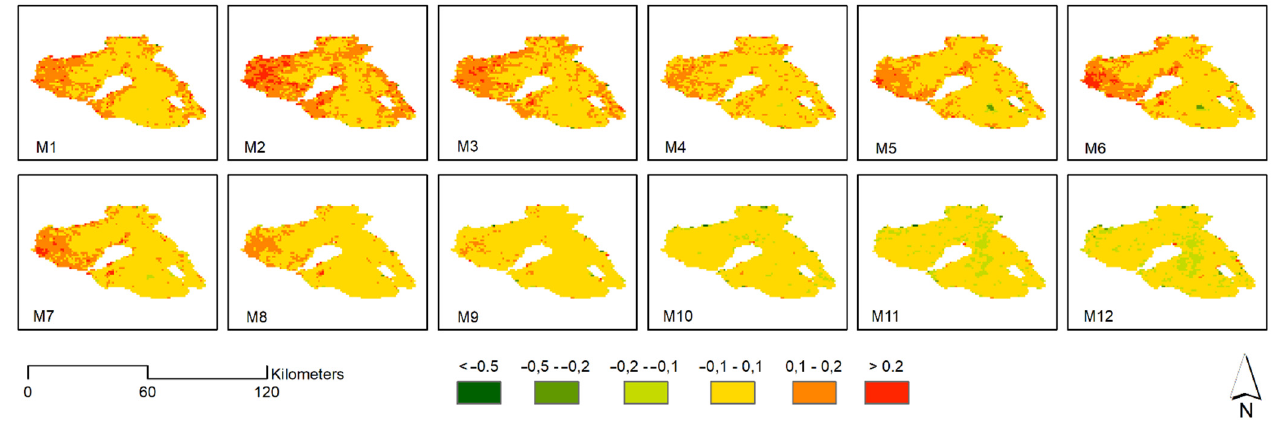
Figure 13. Spatial distribution of the difference between observed and forecasted NDVI of the vali- dation